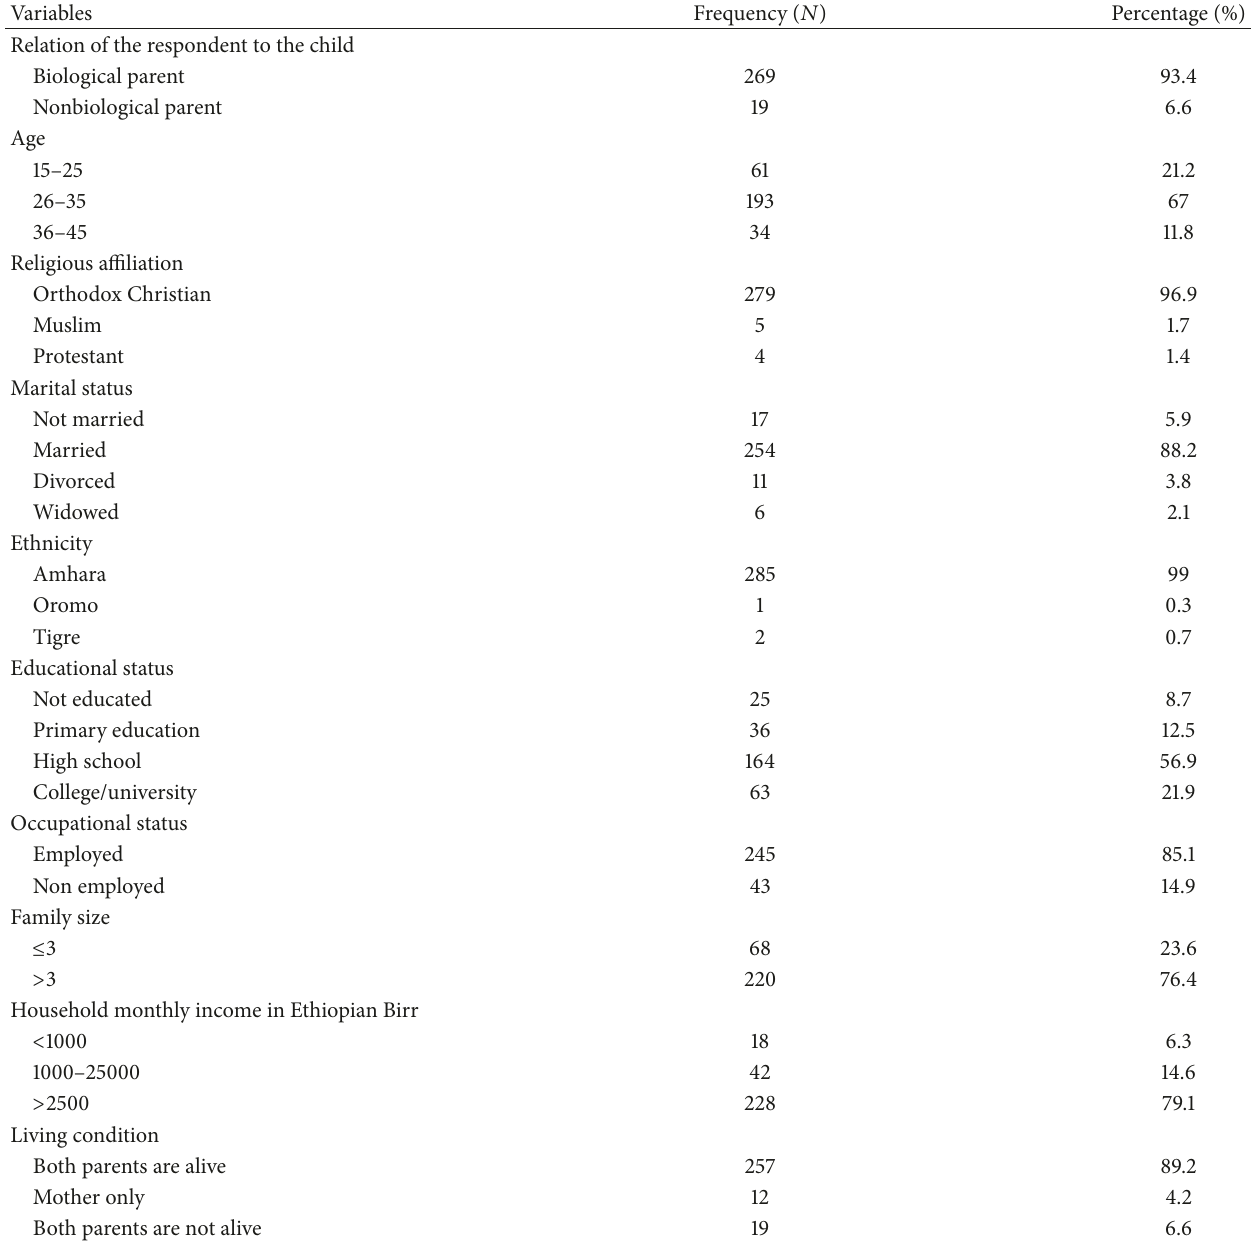
Table 1: Sociodemographic characteristics of parents in Debre Markos town, Amhara Regional State, North West Ethiopia, September 2016. ( 𝑁 = 288